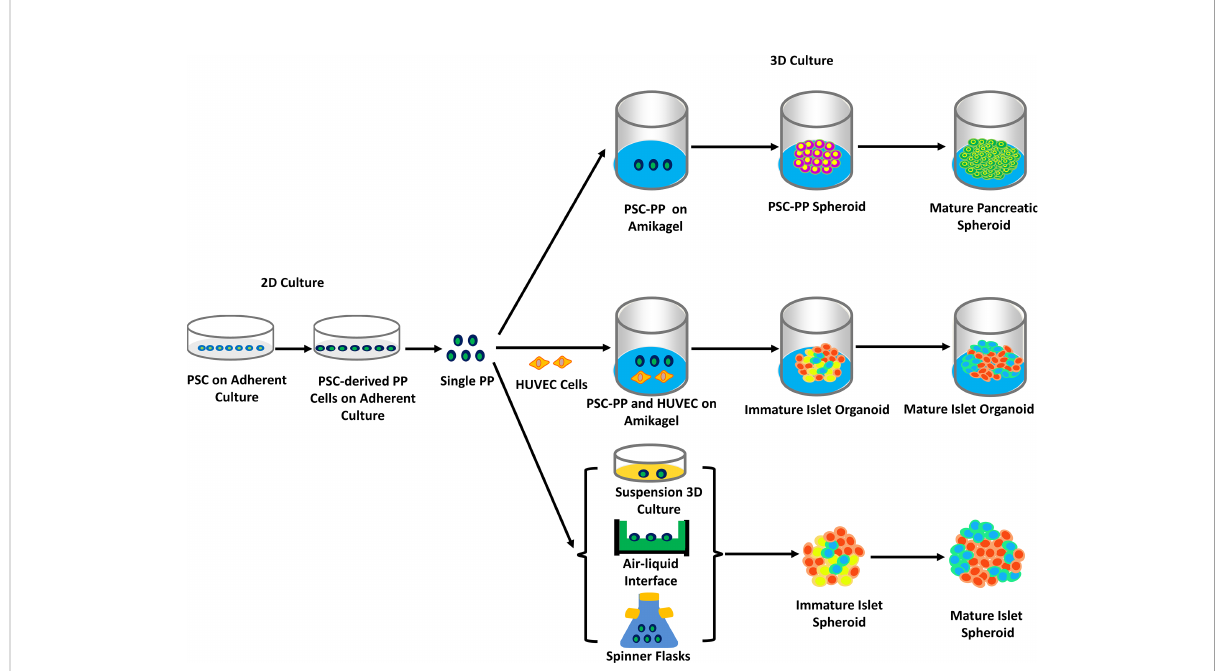
FIGURE 2 The generation of hPSC-derived islet spheroids and organoids on 2D or/and 3D culture. PSCs were grown, differentiated, and eventually turned into pancreatic precursor cells (PSCs-derived PP cells) in adherent culture. PSCs-derived PP cells were seeded to amikagel to form mature spheroids, or together with HUVEC cells to form islet-like organoids. Other methods, such as PSCs-derived PP cells placing in the gas- liquid surface or spinner culture fl asks, form islet spheroids (mainly based on references 20, 21, 74 and 75). Abbreviation. Human endothelial cell,